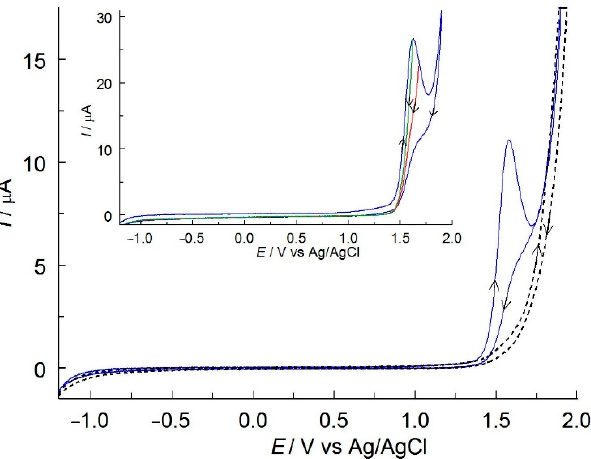
Figure 3. CVs ( v = 50 mV s − 1 ) for MIT oxidation (10.38 mg L − 1 ) recorded on a BDDE in C-PB solution (pH 5.6). The dashed line is the residual current. Inset: CVs ( v = 500 mV s − 1 ). The direction of electrode polarization was reversed from anodic to cathodic at potentials E λ = 1.6; 1.7; 1.9 V.